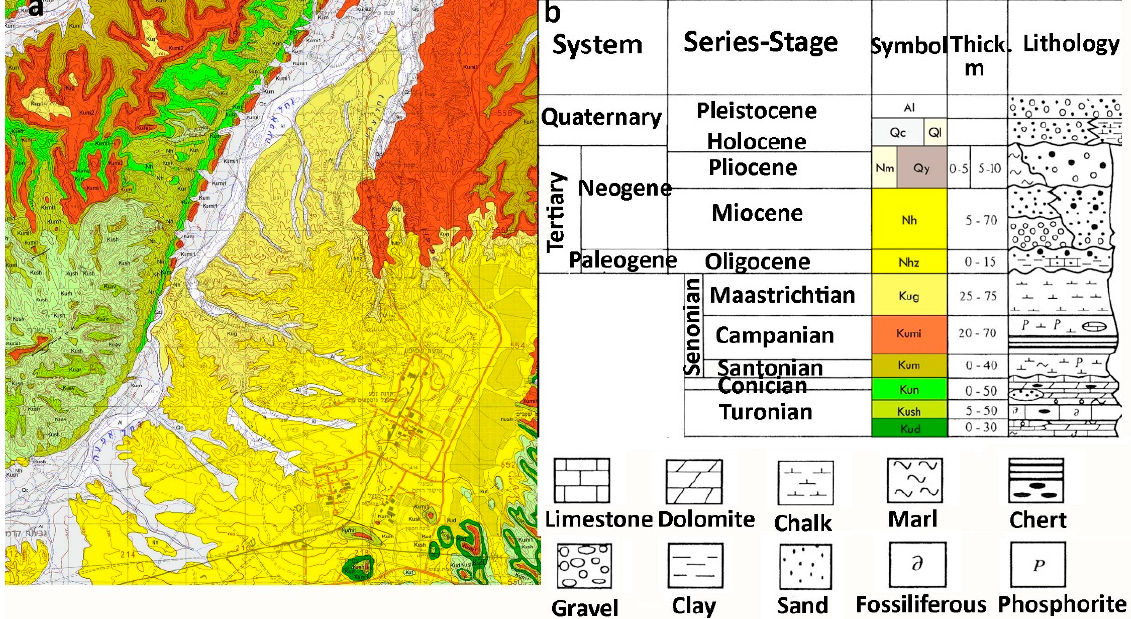
Figure 2. Geological information on the Mishor-Rotem region: ( a ) the map, ( b ) the stratigraphical elements (modified from [5]).